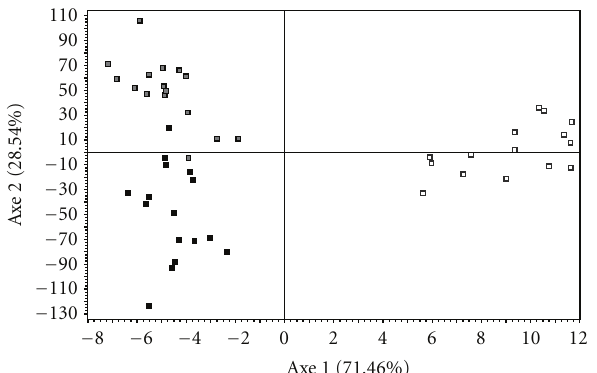
Figure 5: Correspondence analysis: projection of the individuals on the plane defined by the first two axes. Black, white, and grey dots codifying for GRA, NAV, and RIL populations,